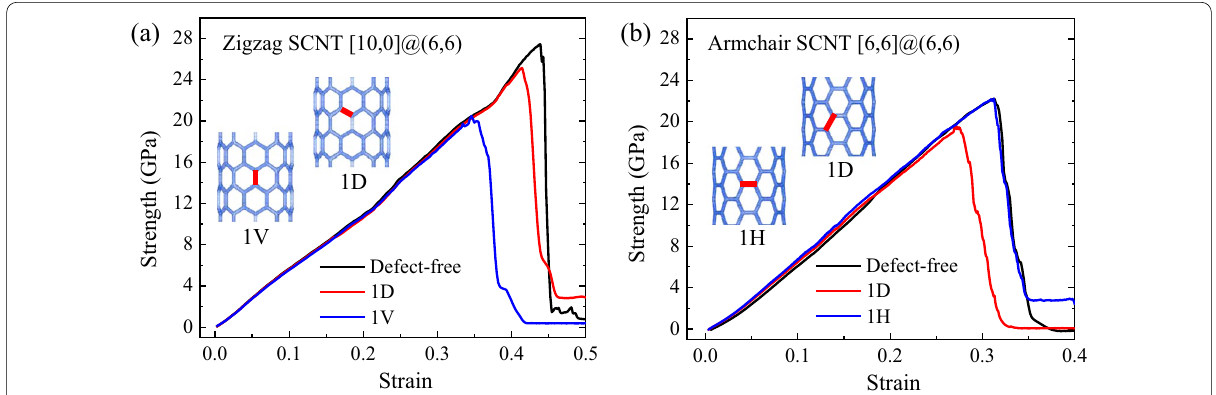
Fig. 3 Stress–strain curves of the single-defect SCNTs compared with the defect-free SCNTs. a Zigzag SCNT; b Armchair